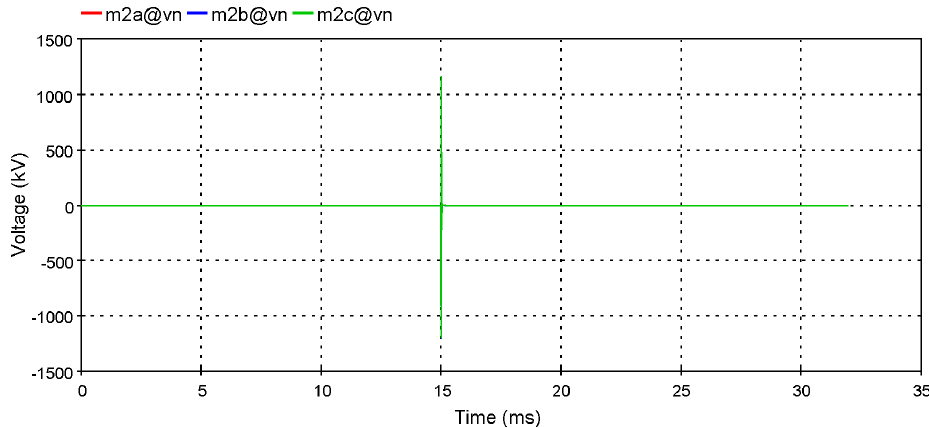
Figure 6. Overvoltage at the primary side of transformers.